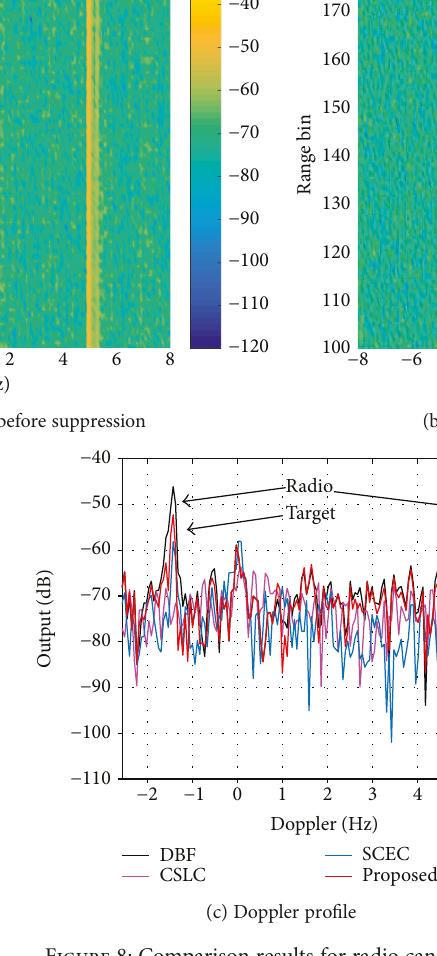
Figure 8: Comparison results for radio cancellation.